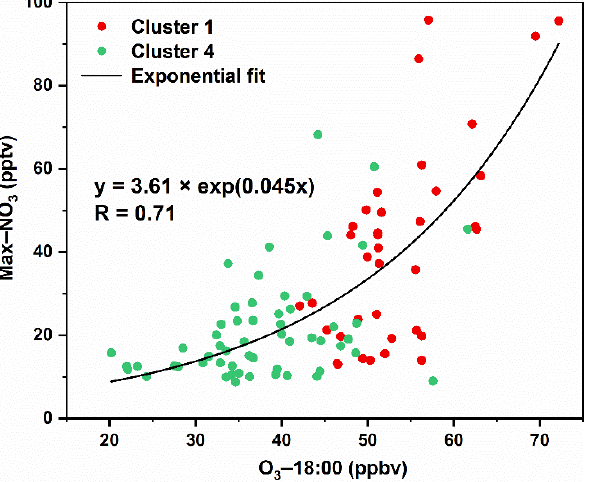
Figure 9. The daily O 3 concentration at 18:00 and the maximum concentration of NO 3 between 18:00 and 23:00 in clusters 1 and 4.